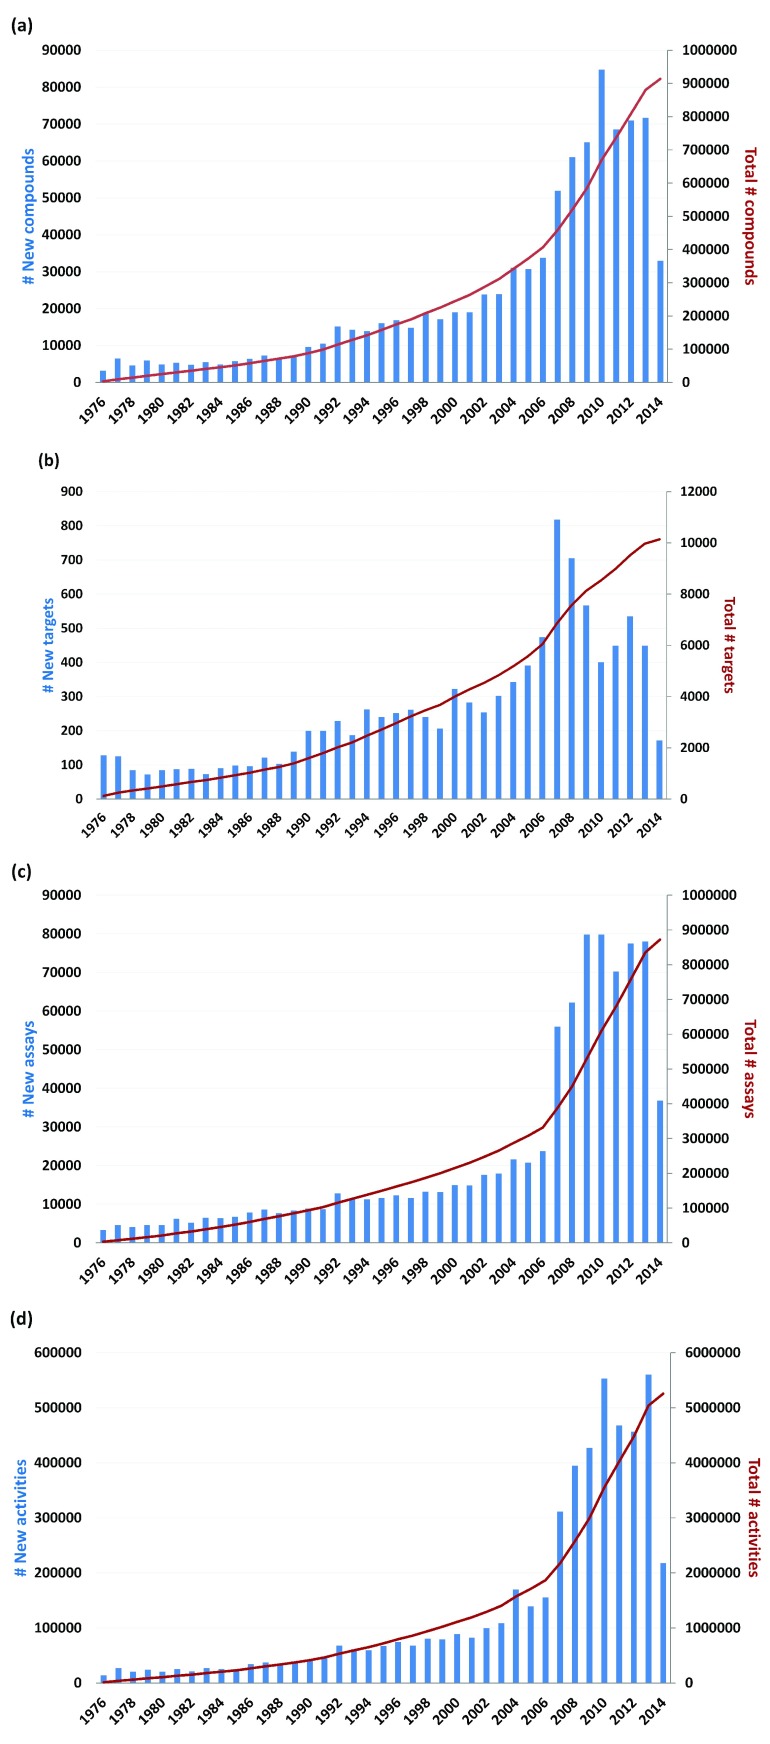
Growth of compounds, targets, assays, and activity records.The growth of compounds (
a), targets (
b), assays (
c), and activity records (
d) is reported. In (
a), the number of new compounds becoming available each year is provided using blue bars (scale on the left vertical axis) and the cumulative number of compounds is given as a red line (scale on the right). Corresponding representations are used in (
b)–(
d).